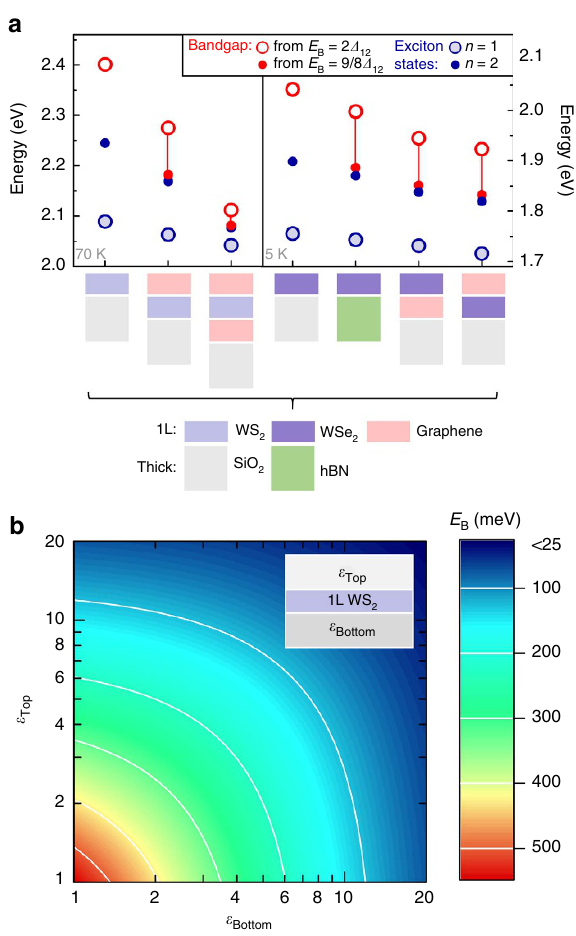
Figure 3 | Influence of the choice and configuration of materials on the dielectric tuning of the bandgap. ( a ) Experimentally measured exciton ground state ( n ¼ 1) and the first excited state ( n ¼ 2) transition energies, as well as the estimated shifts of the bandgap for a variety of heterostructures. Their respective stacking configurations are indicated along the horizontal axis. The bandgap is obtained by adding the exciton binding energy to the measured transition energy of the n ¼ 1 state. To estimate the binding energy from the energy separation of the exciton states D 12 , we considered the limiting cases of a non-hydrogenic scaling from ref. 24 E B ¼ 2 D 12 ð Þ and the 2D-hydrogen model E B ¼ 9 = 8 D 12 ð Þ . ( b ) An overview of predicted changes in the exciton binding energy in 1L WS 2 , encapsulated between two thick layers of dielectrics. The binding energy E B is calculated by using the electrostatic approach in the effective mass approximation and presented in a 2D false-colour plot as a function of the top and bottom dielectric constants. The changes in the magnitude of E B are roughly equal to the corresponding shifts of the bandgap and can reach 500meV. different spatial position x on the sample; the bilayer graphene flake covers the WS 2 monolayer between 5 and 12 m m on the x axis. Like the data shown in Fig. 1d,e, both the ground and excited state resonances of the WS 2 excitons shift to lower energies in the presence of graphene. The peak energies are extracted from the points of inflection of the derivative, indicated by circles in Fig. 4a,b. The appearance of multiple transitions in the same spectrum reflects the limited spatial resolution (1 m m) and a small amount of the WS 2 monolayer not being in close contact with graphene (see Supplementary Note 1 and Supplementary Fig. 2 for details). NATURE COMMUNICATIONS|8:15251|DOI: